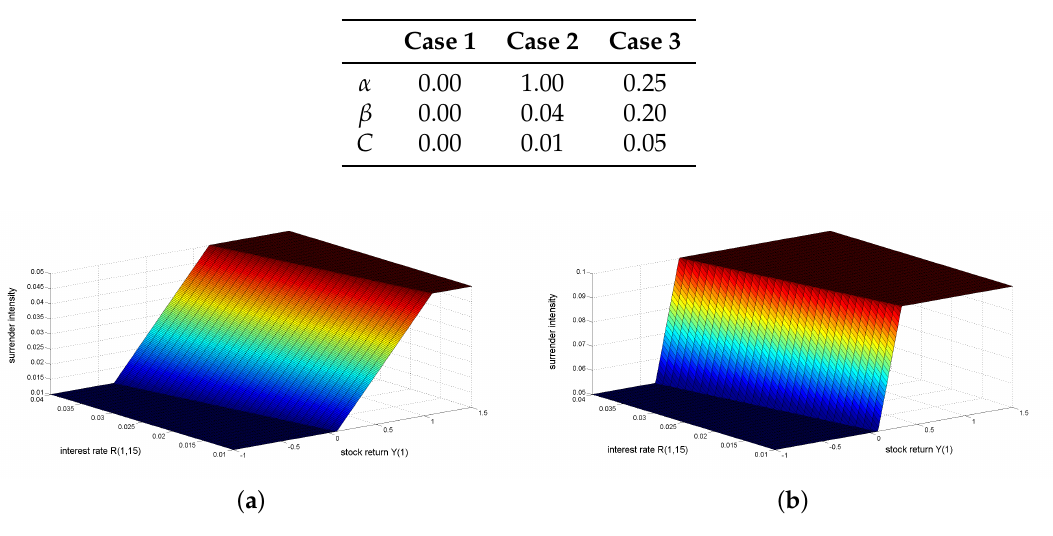
Table 5. Parameters of Surrender Model.